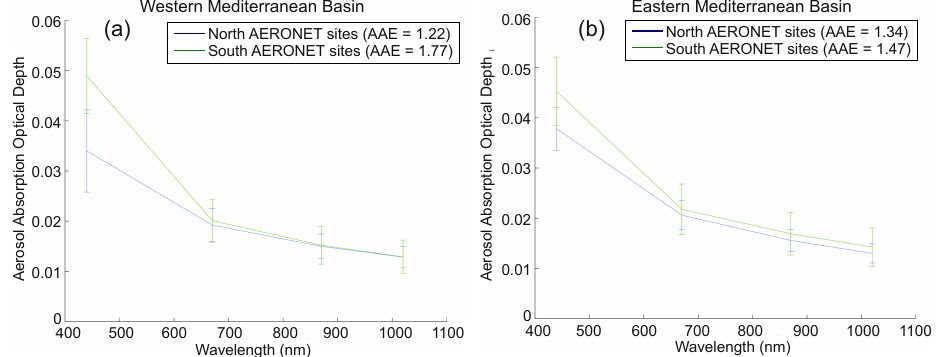
Fig. 9. Wavelength dependence of Aerosol Absorbing Optical Depth (AAOD) for Northern and Southern AERONET sites classified over the (a) Western and (b) Eastern basins. Associated standard deviations and mean AAE (calculated between 440 and 880nm) are also